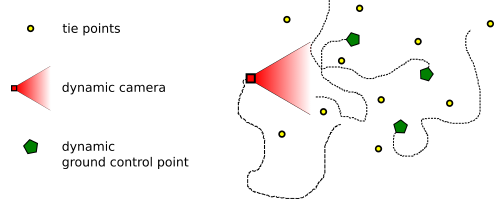
Figure 1. Basic scenario with one dynamic camera and dynamic GCPs moving between static tie